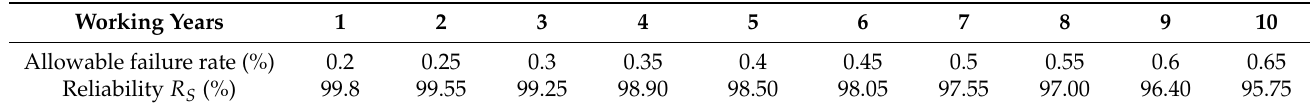
Table 5. Allowable annual failure rate over the lifetime.